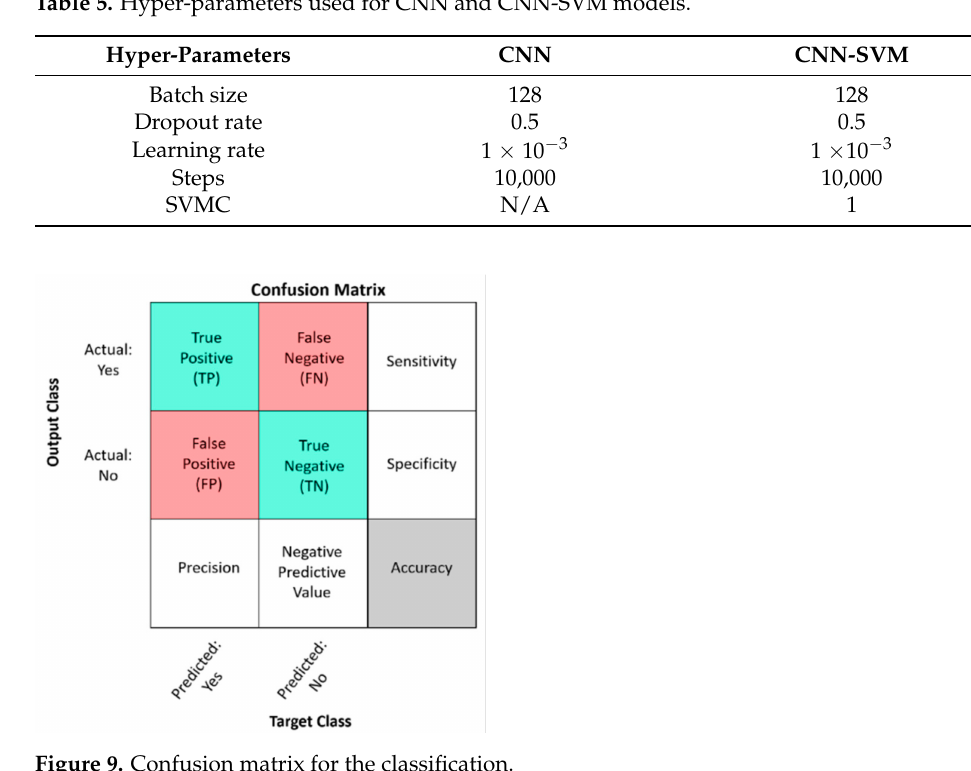
Figure 9. Confusion matrix for the